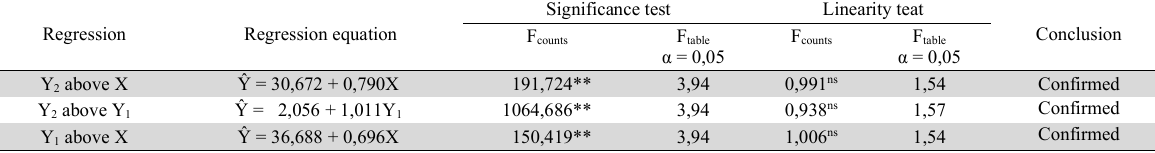
Summary of Significance Test Results and Regression Linearity Tests Regression Regression equation